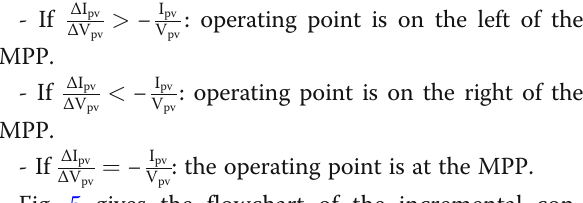
Fig. 5 gives the flowchart of the incremental con- ductance which respects previous conditions. As